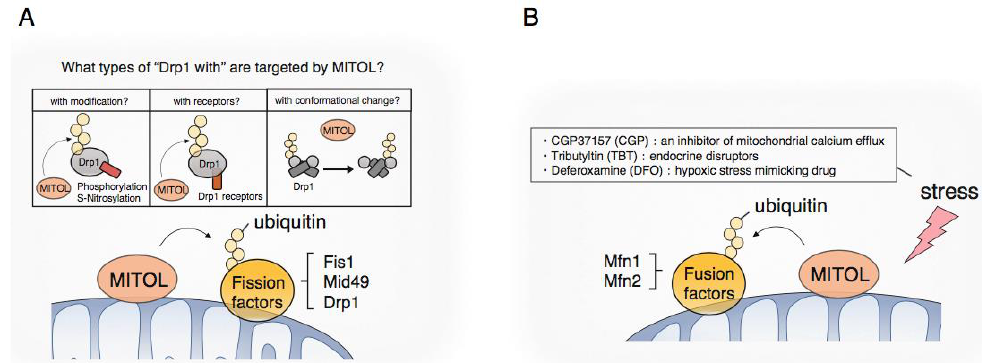
Figure 3. Regulation of mitochondrial fission and fusion factors by MITOL. ( A ) MITOL might have some specificity for its target; e.g., especially Drp1, such as relating to modifications, structural changes, and interactions with or without Drp1 receptors; ( B ) Alteration of substrate specificity for mitochondrial fusion factors in response to stress.